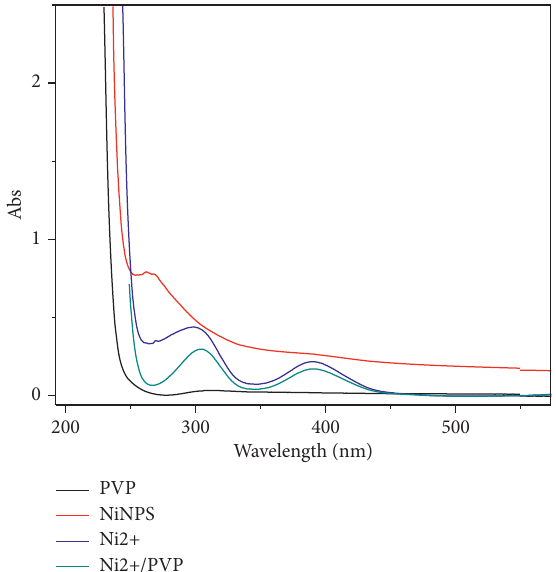
Figure 1: UV-vis spectra of nickel nanoparticles solution and reference